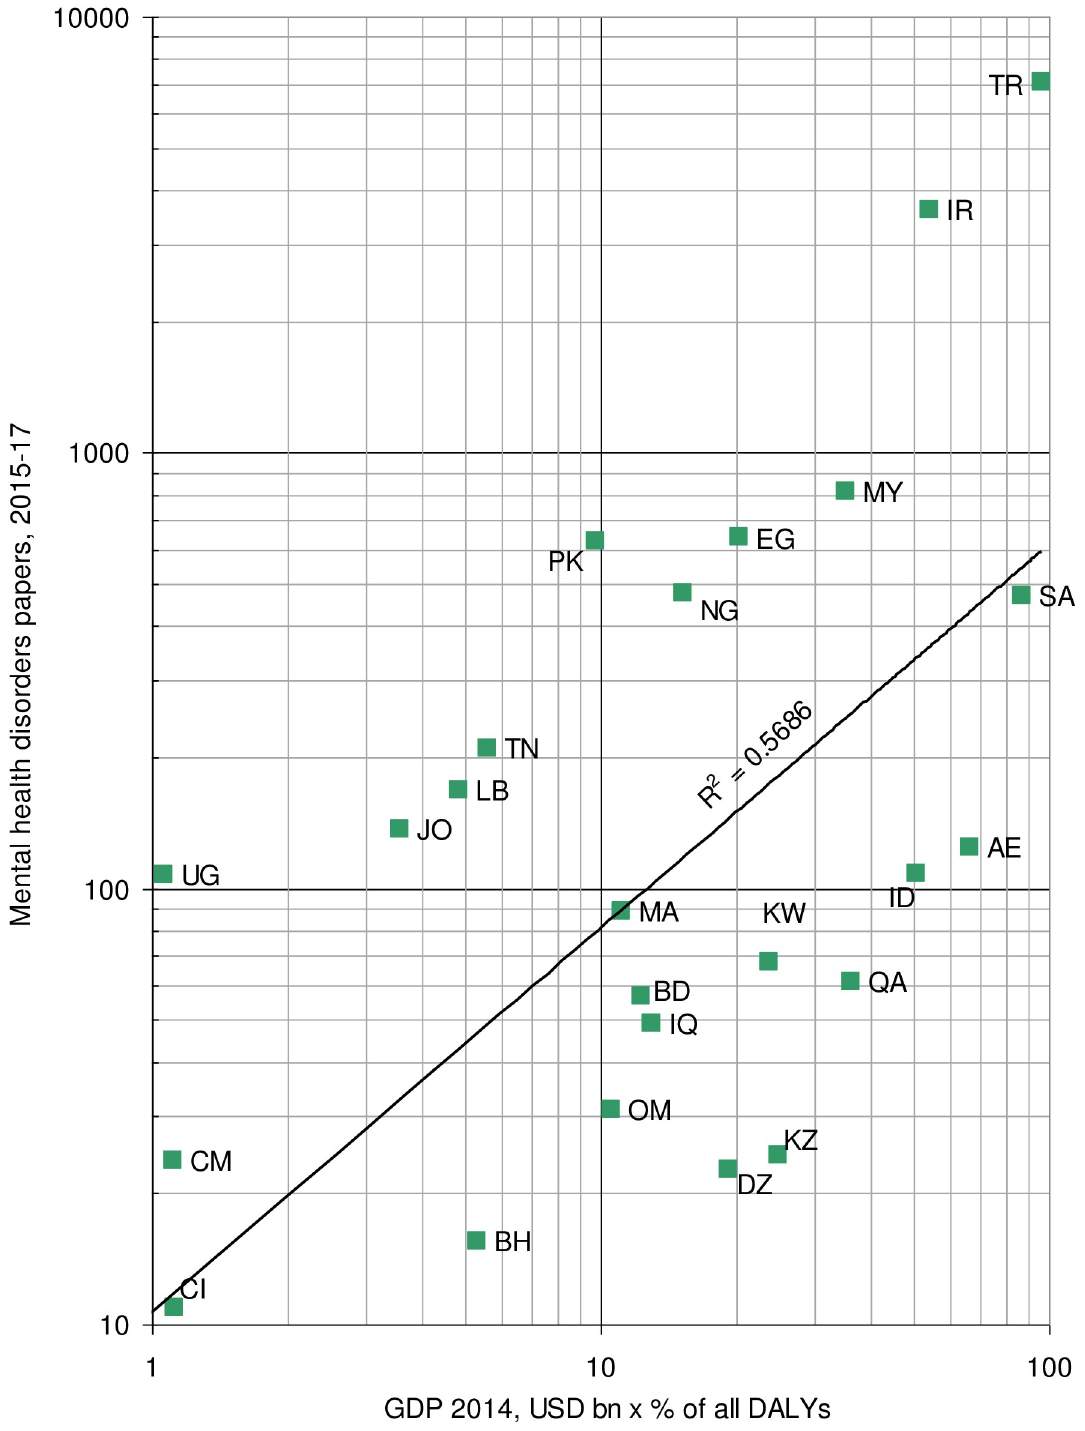
Fig 1. OIC country outputs of mental disorders papers, 2015–17 compared with their wealth multiplied by the percentage of all DALYs in 2015 from mental disorders.